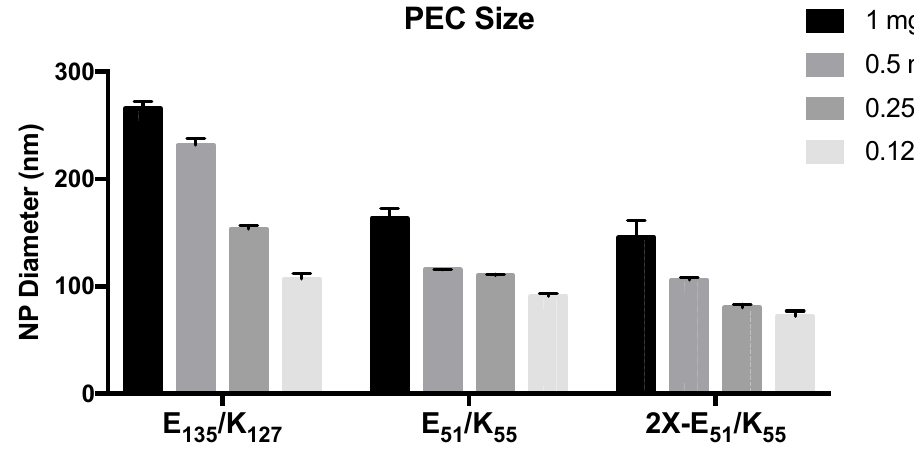
Figure 1. Size summary of poly( L -Lysine) (K n ) and poly( L -Glutamic Acid) (E n ) polyelectrolyte complexes (PECs). PECs were formulated at 1:1 or 1:2 molar charge ratios of E n :K n with the indicated degree of polymerization (DP n ) and beginning from an E n concentration of 1 mg/mL. Decreasing the DP n of poly( L -Lysine) and poly( L -Glutamic Acid) from 127/135 to 55/51 resulted in a statistically significant decrease in diameter at all concentrations tested. All formulations demonstrated concentration dependence in diameter. Data shown are hydrodynamic diameter as determined by dynamic light scattering (DLS) and are the averages over 3–4 wells ± standard deviation. Results were analyzed by two-way ANOVA.